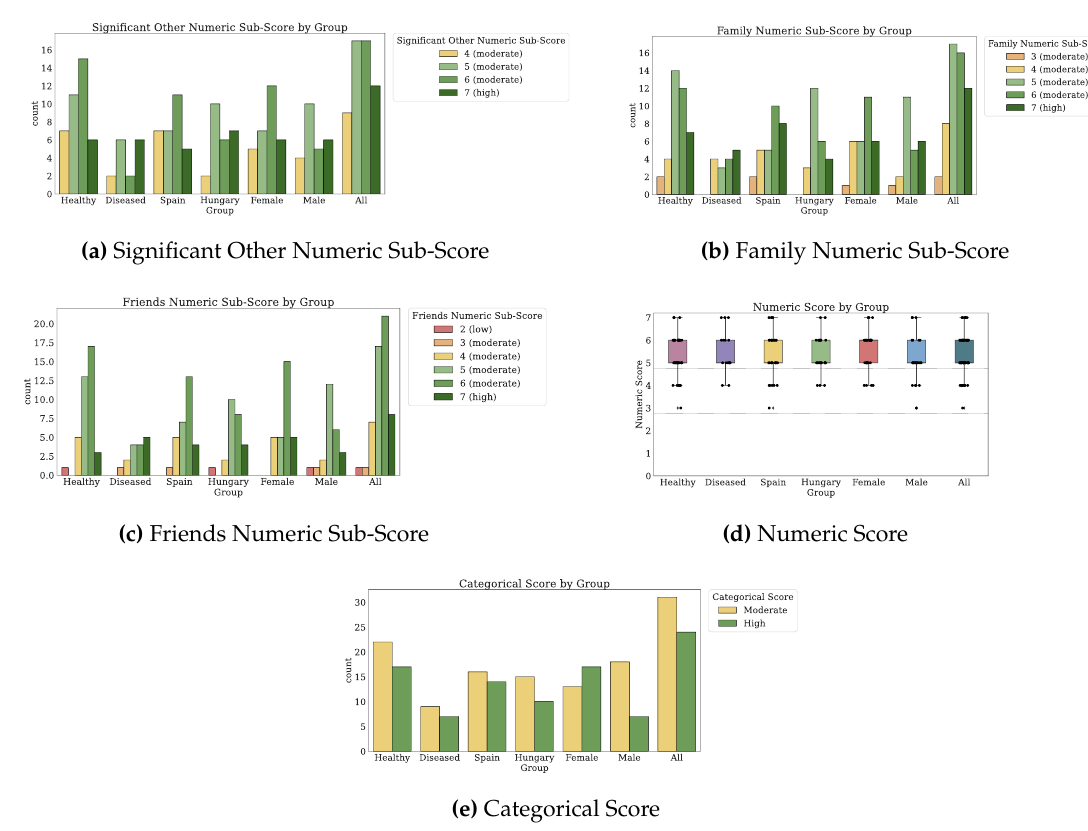
Figure A4. Sub-scores and Scores for Social Support (MSPSS). Dotted markings delimit levels of the categorical